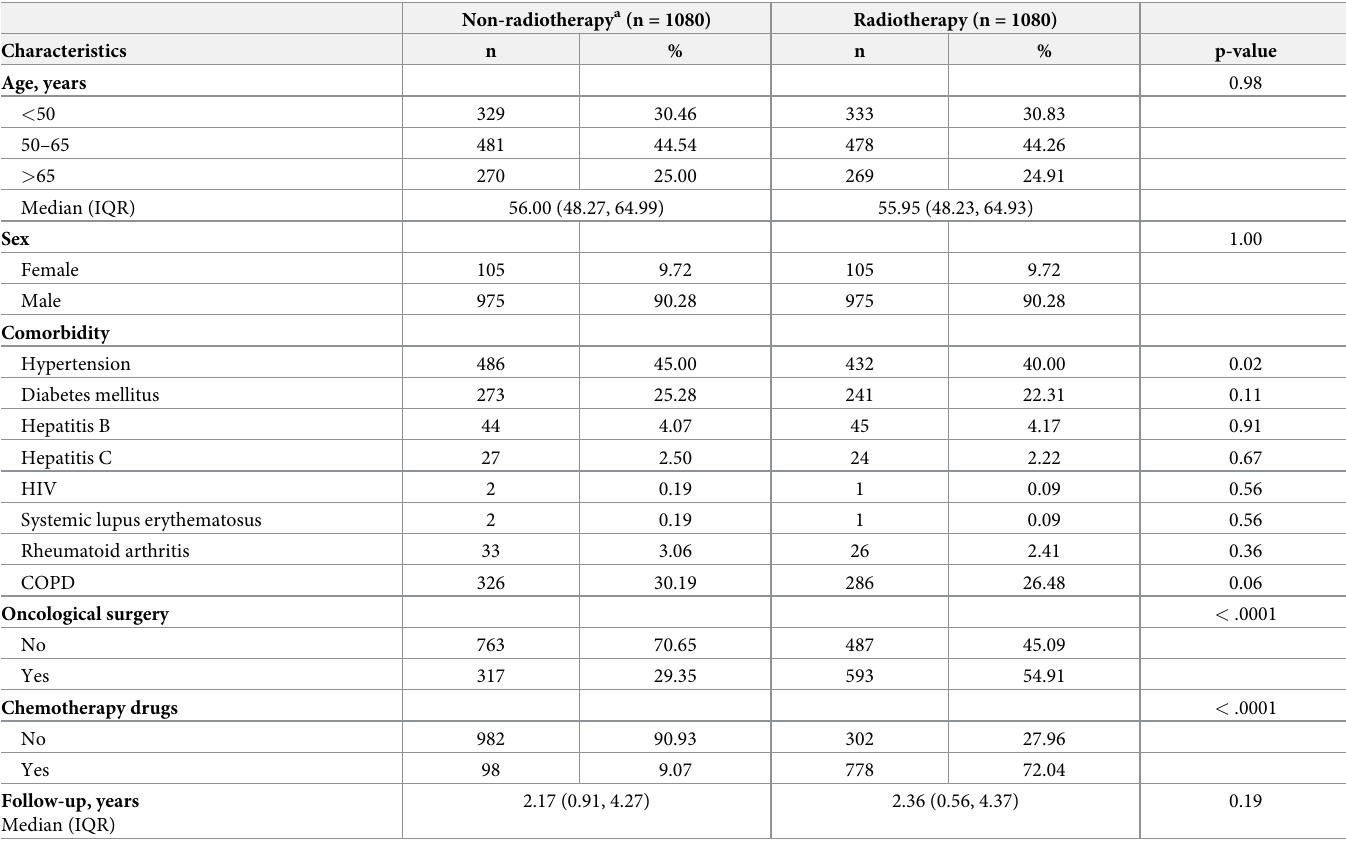
Table 1. Demographic data and treatment-related factors in the RT and non-RT cohorts. Non-radiotherapy a (n =